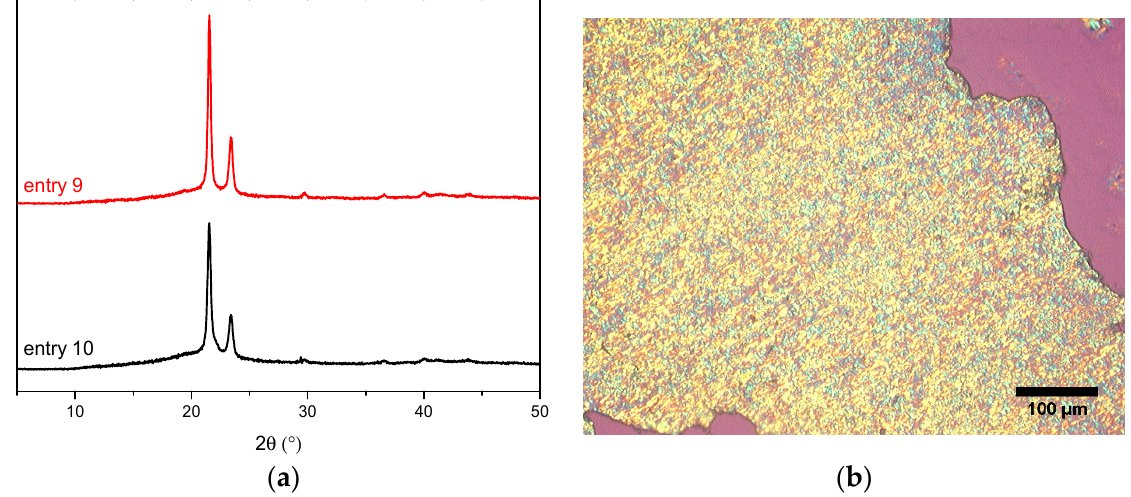
Figure 6. ( a ) Representative WAXD spectra of TBHM-based polymers and ( b ) POM image of polyester synthesized from TBHM and 1,12-dodecanediol (entry 10, Table 1).